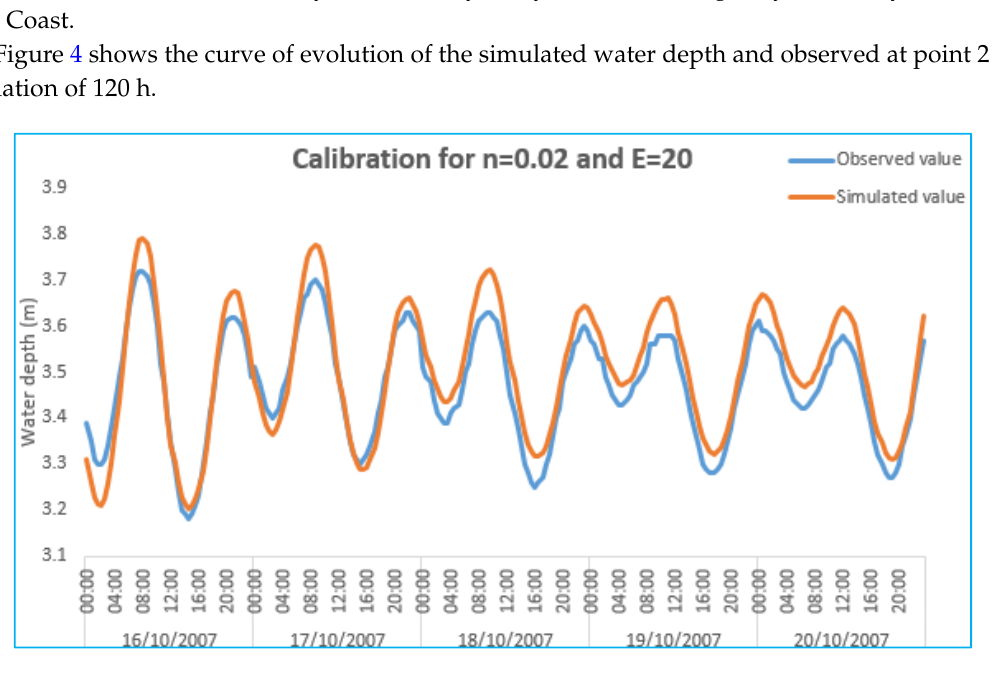
Figure 4. Variation of the water depth observed and simulated during calibration.